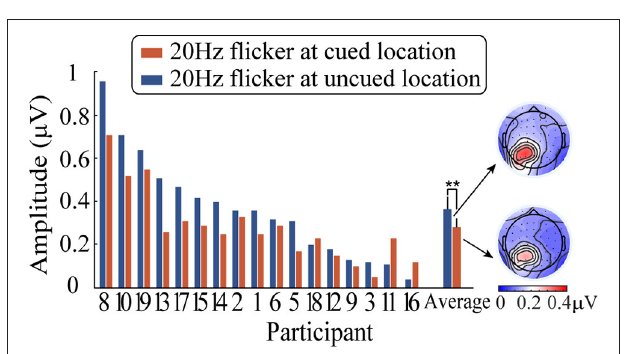
FIGURE 4 | SSVEP amplitudes elicited by a 20 Hz flicker stimulus when it was cued (blue) and uncued (red) as well as the corresponding topographic maps. ** indicates p <